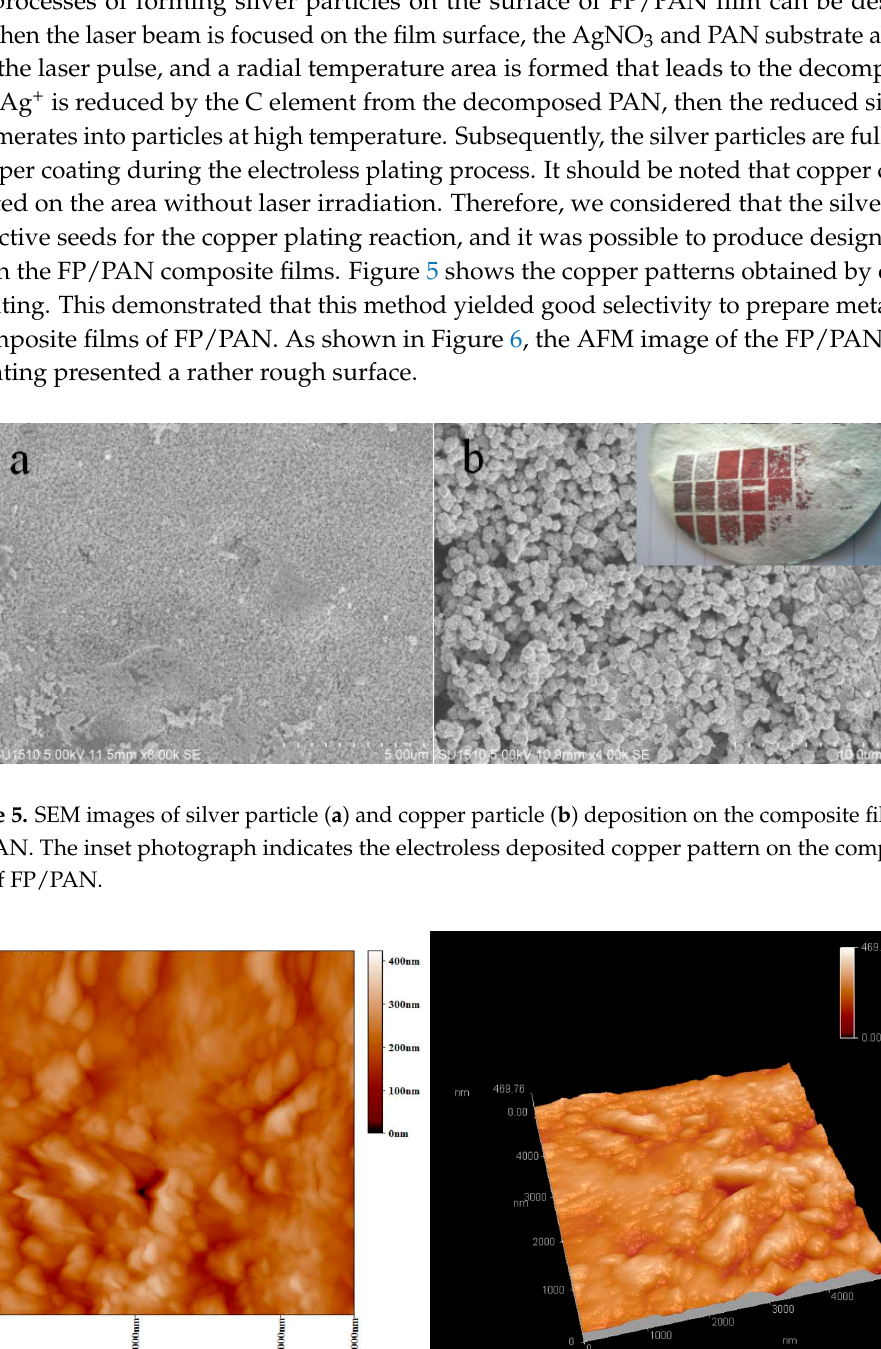
Figure 7. I–V curves of electroless deposited copper patterns on the composite films of FP/PAN. 4. Conclusions We reported a method using laser-induced deposition silver on FP/PAN composite films for selective electroless plating copper. The Ag+ iron was doped into a composite film and selectively reduced to silver particles using a pulsed laser source. Then, copper was deposited by means of electroless plating with silver particles as the seeds. The experimental results demonstrated that the scanning speed of the laser pulse greatly affected the redox reaction. The I–V curve indicated that the copper patterns on the FP/PAN composite films had good conductivity. This method provides new insight into preparing a flexible circuit board.